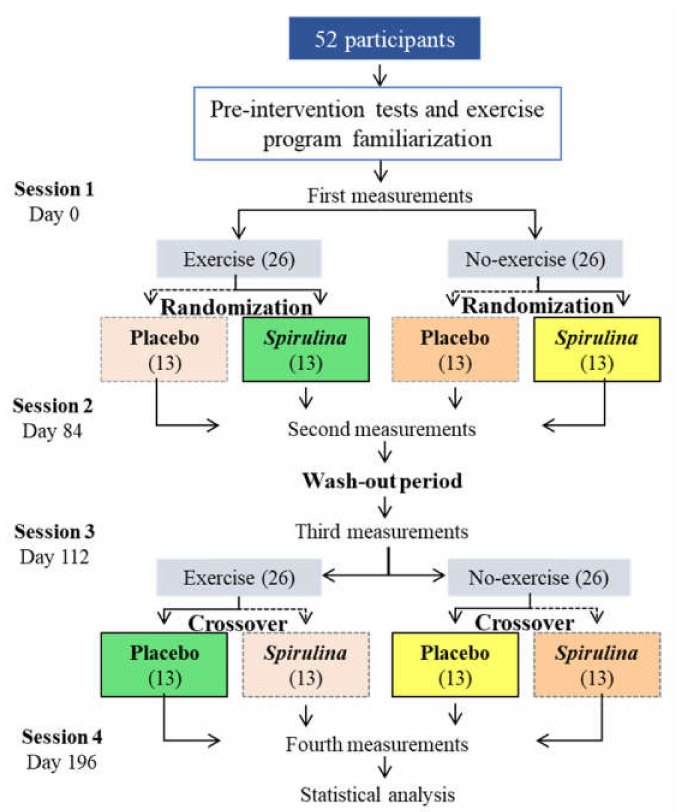
Figure 1. Flow diagram of the experimental design for the impact of Spirulina maxima intake and exercise (SIE) trial. Same color indicates the same group of